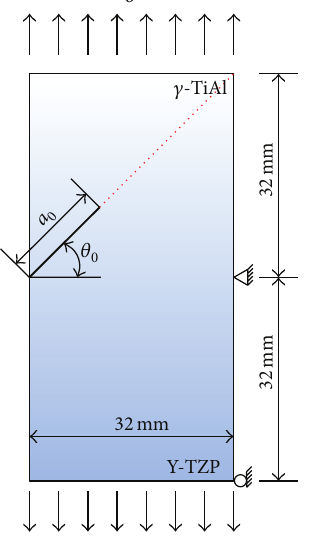
Figure 14: Geometry and boundary conditions for dynamic crack propagation under time-independent loading.